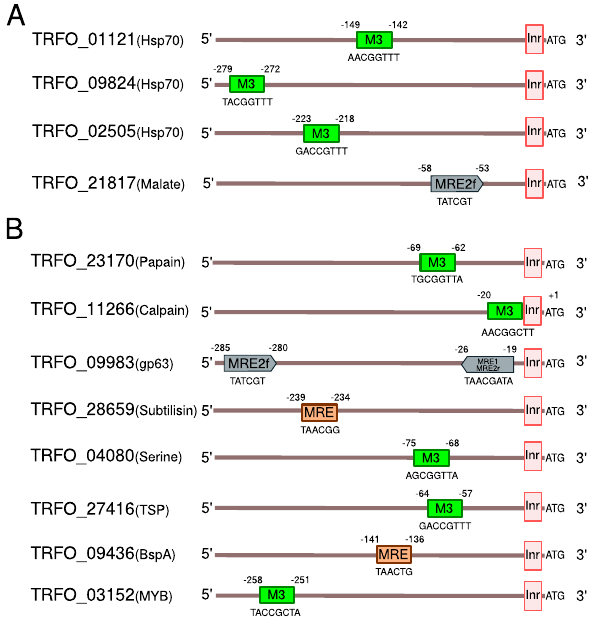
Figure 5. Predicted promoters from Tritrichomonas foetus genes with MYB binding motif. ( A ) A schematic representation of predicted promoters and the predicted MYB binding motifs from genes related to Hsp70 family and malic enzymes; ( B ) Representation of predicted promoters and the predicted MYB binding motifs for genes related to virulence and adaptive factors studies in this